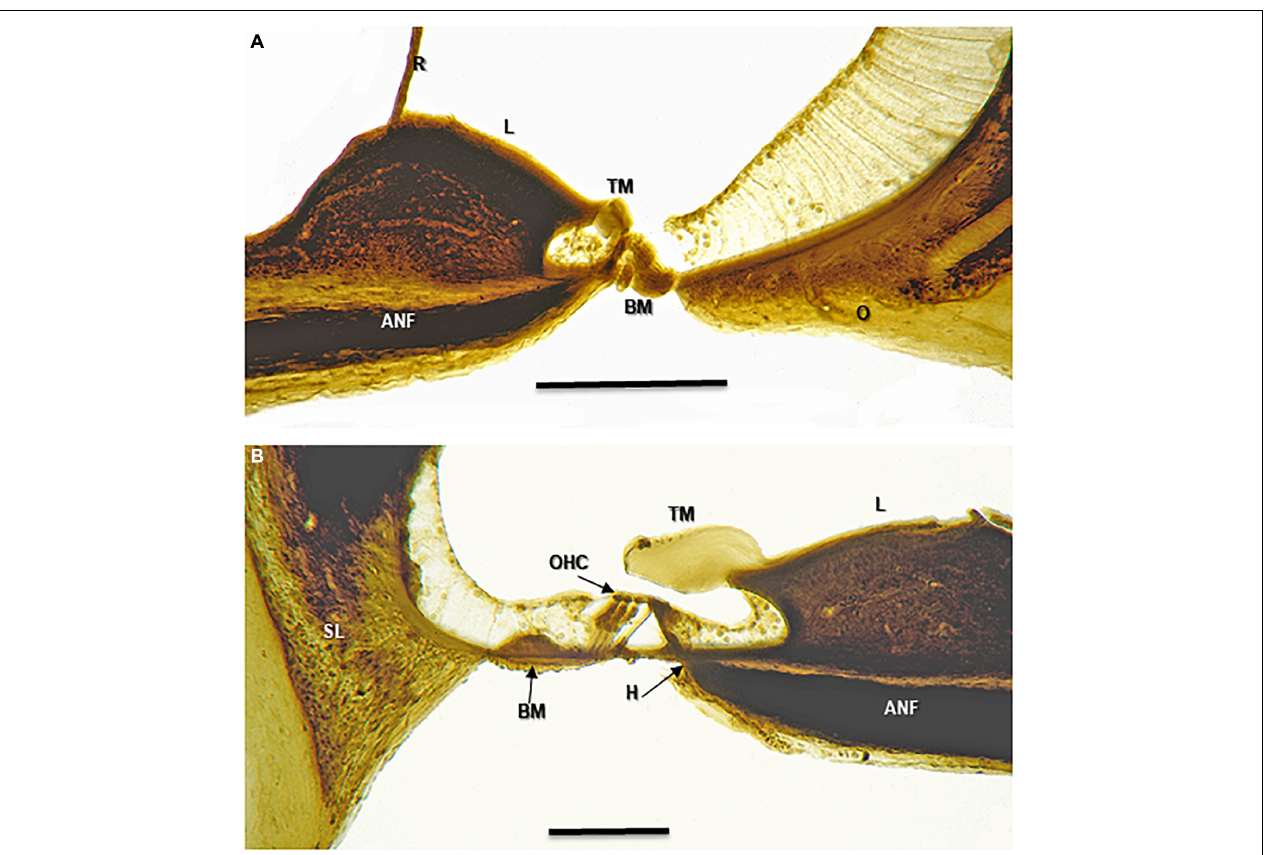
FIGURE 4 | Osmium tetroxide stained 25 micron sections of the of a harbor porpoise ( P. phocoena ) cochlea. These images should be compared with the TEM and schematic images in Figure 5 . ANF, auditory nerve fiber; BM, basilar membrane; H, habenula; L, spiral limbus; O, outer spiral lamina; OHC, Outer hair cells; R, Reissner’s membrane; SL, spiral ligament; TM, tectorial membrane. Scale bars = 0.1 mm. (A) Lower basal turn. (B) Mid apical turn. Images copyright© 2020 DK, all rights